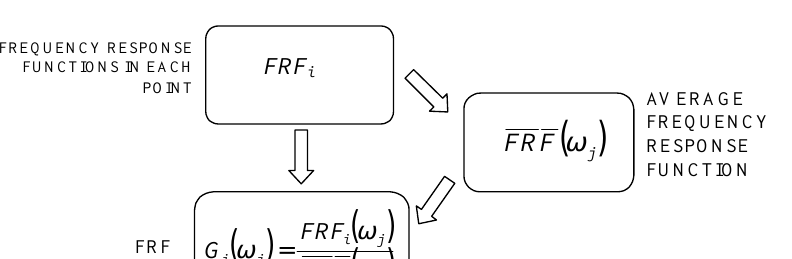
Fig. 3. Data processing flow in a M.L.P. network with 1 hidden layer.